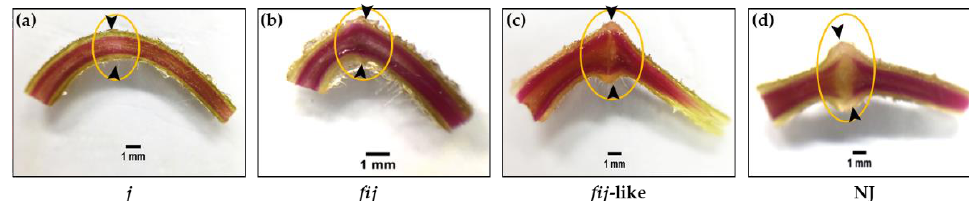
Figure 2. Phloroglucinol staining for lignification of AZs in ( a ) jointless (j), ( b ) functionally impaired jointless (fij), ( c ) functionally impaired jointless like (fij like), and ( d ) normal joint (NJ) pedicels. The unstained cleft was observed to be greater for the NJ variant, signifying the unlignified layers of cells in the AZ compared to fij like, whereas the pattern of lignification in the vascular system of the j and fij pedicels remained unaltered throughout the pedicel. Arrowheads indicate the junction of AZs in each variant. Bar = 1 mm.